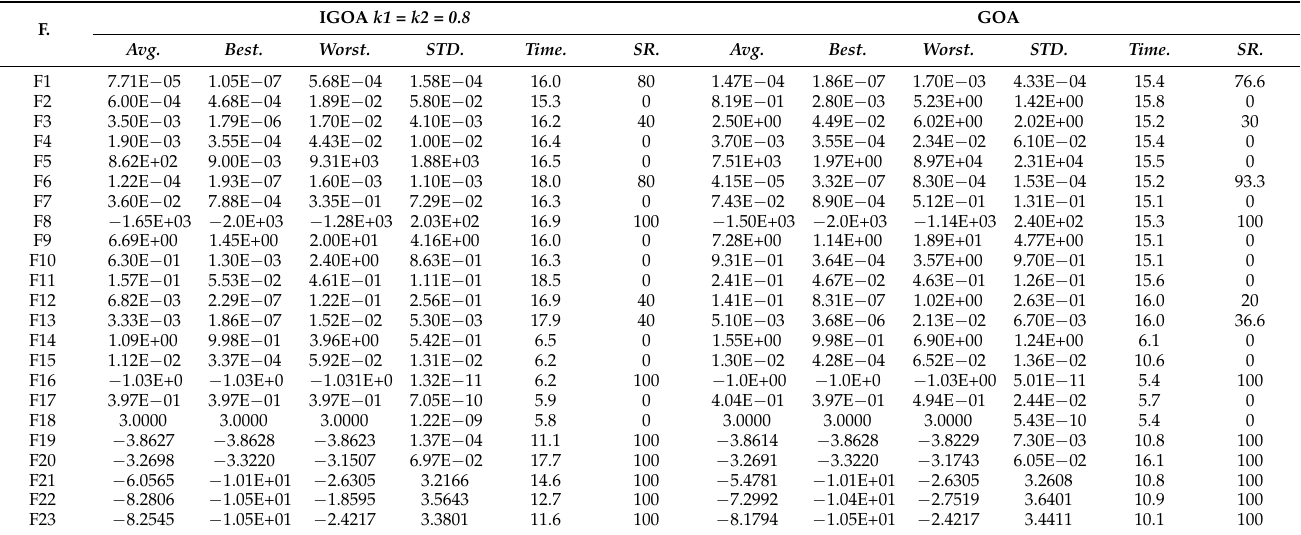
Table 3. Comparison between IGOA ( k 1 = k 2 = 0.8 ) and original GOA.